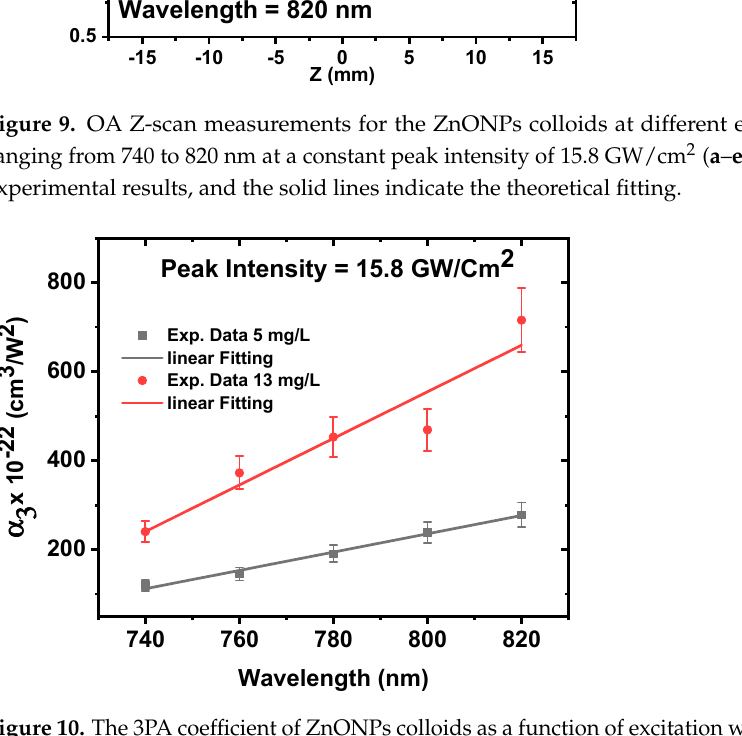
Figure 8. OA Z-scan measurements for the ZnONPs colloids at different excitation wavelengths ranging from 740 to 820 nm at a constant peak intensity of 15.8 GW/cm 2 ( a – e ). The dots indicate the experimental results, and the solid lines indicate the theoretical fitting.